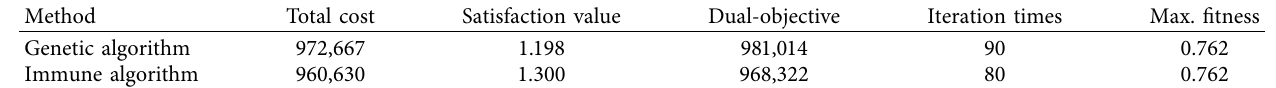
Table 3: Comparison between the genetic algorithm and immune algorithm.